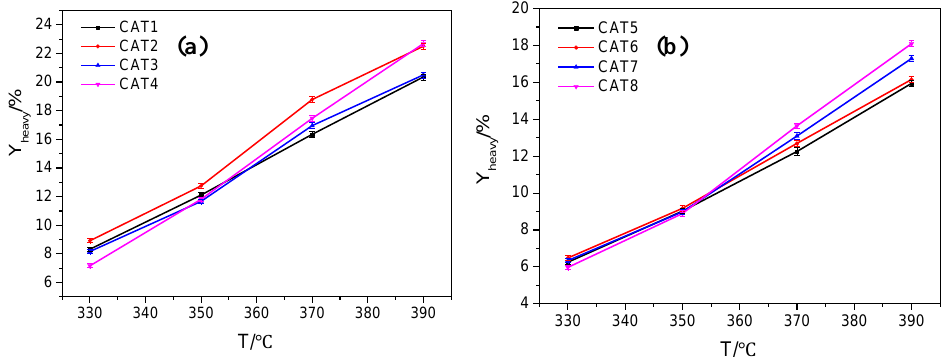
Figure 11. The relationship between yields of Y heavy and temperature over catalysts ( a ) CAT1-CAT4 and ( b ) CAT5-CAT8.